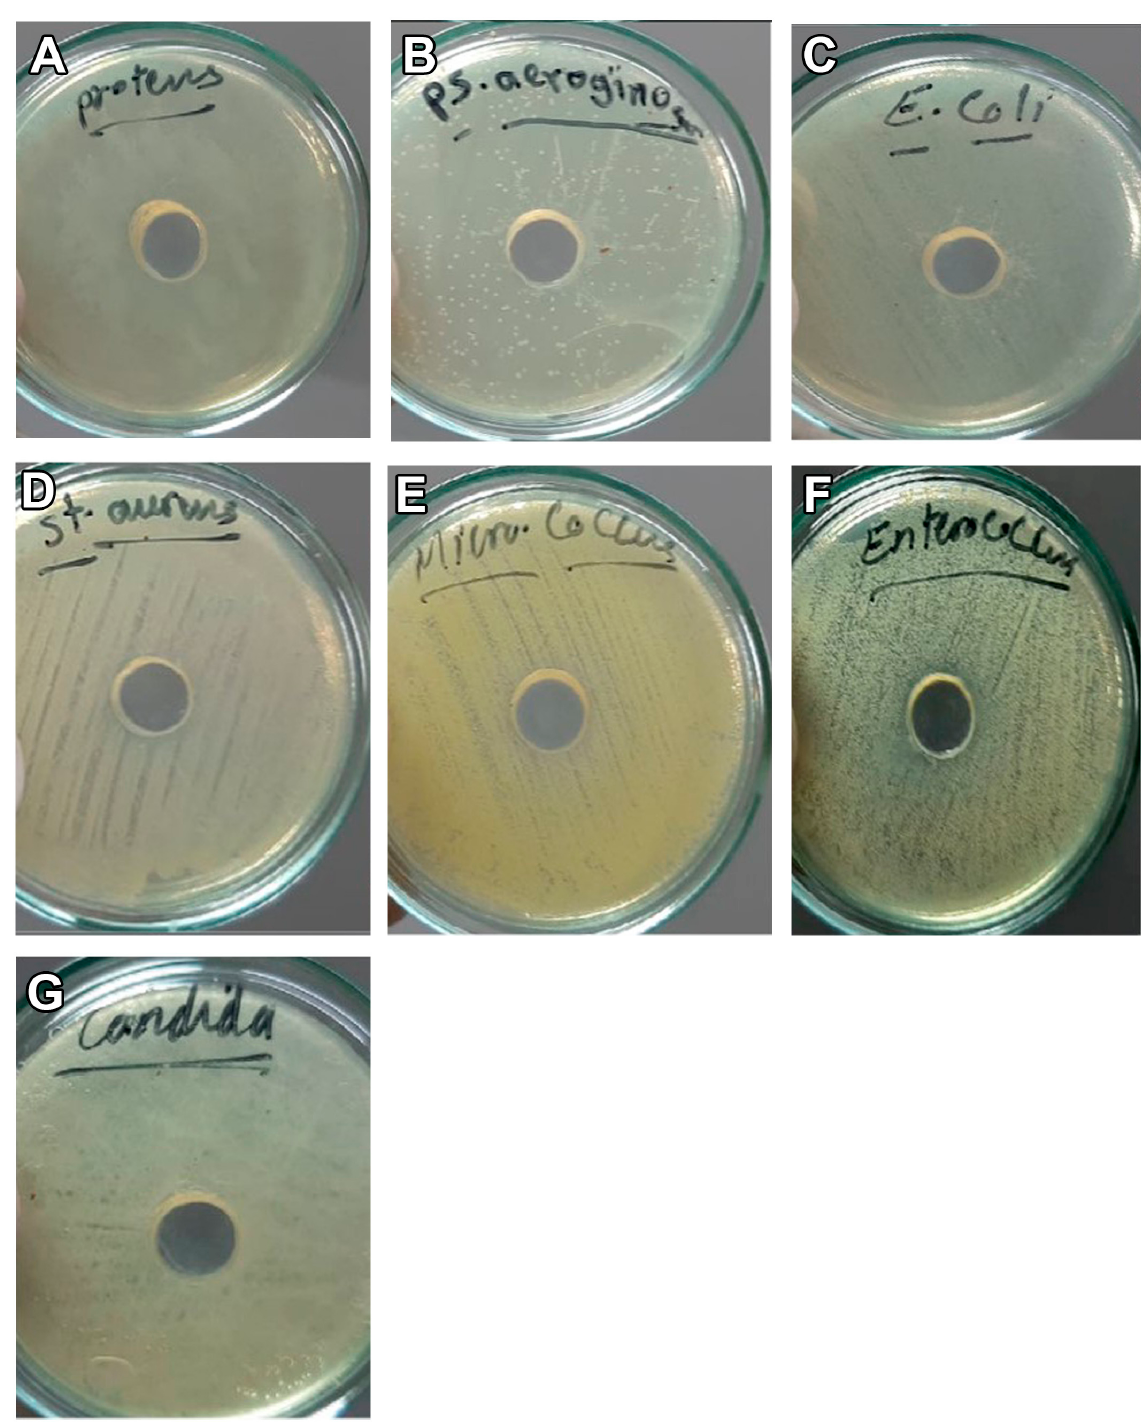
Figure 3. Inhibition zone assay shows the effect of CM-EXOs on Gram-negative bacteria: P. mirabilis ( A ), P. aeruginosa ( B ) and E. coli ( C ), Gram-positive bacteria: S. aureus ( D ), M. luteus ( E ), and E. feacalis ( F ), and fungi, C. albicans ( G ).